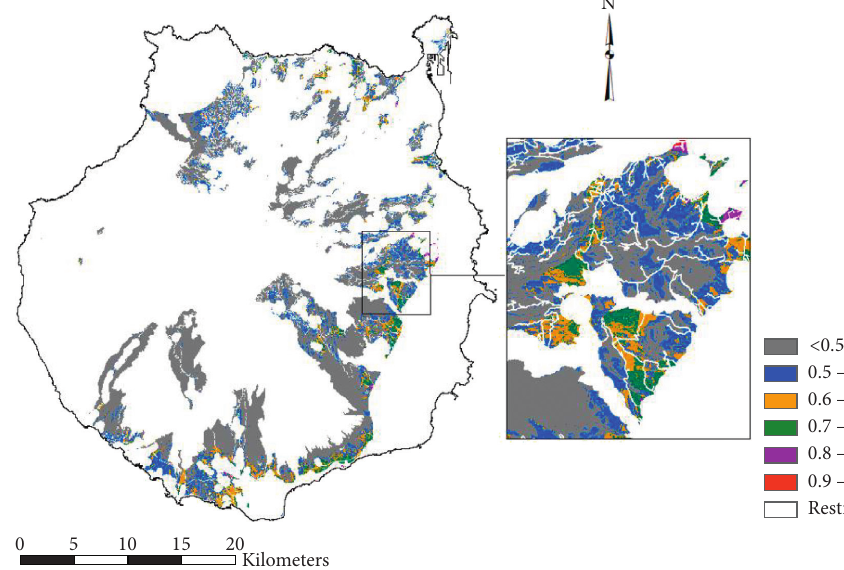
Figure 14: Wind suitability map (equal weights’ criterion).